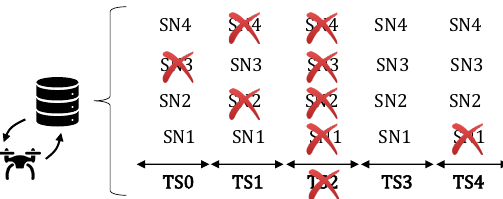
Figure 9. Example of the Prohibition List managed by the UAV during the reconfiguration phase.